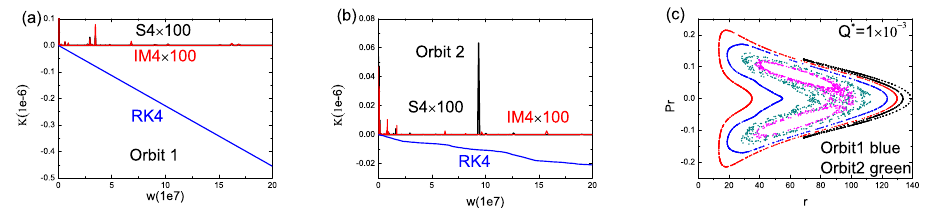
Figure 5. ( a , b ): Accuracies of the time-transformed Hamiltonian K yielded by three methods S4, IM4, and RK4 acting on Orbit 1 and Orbit 2. The time-step is h = 1. Orbits 1 and 2 have their initial separations r = 55 and r = 75, respectively. The other initial conditions are θ = π /2, p r = 0 and p θ > 0. The parameters are E = 0.9935, L = 4.6, B ∗ = 0.001, a = 0.5, and Q ∗ = 0.001. Symbol “ × 100” means that the plotted errors are enlarged 100 time compared with the practical errors. ( c ) Poincaré sections at plane θ = π /2 with p θ > 0. The black orbit has its initial separation r = 25, the red orbit has the initial separation r = 35, and the pink orbit has the initial separation r = 100. Orbit 1 is regular, whereas Orbit 2 and the pink orbit with the initial separation r = 100 are chaotic.